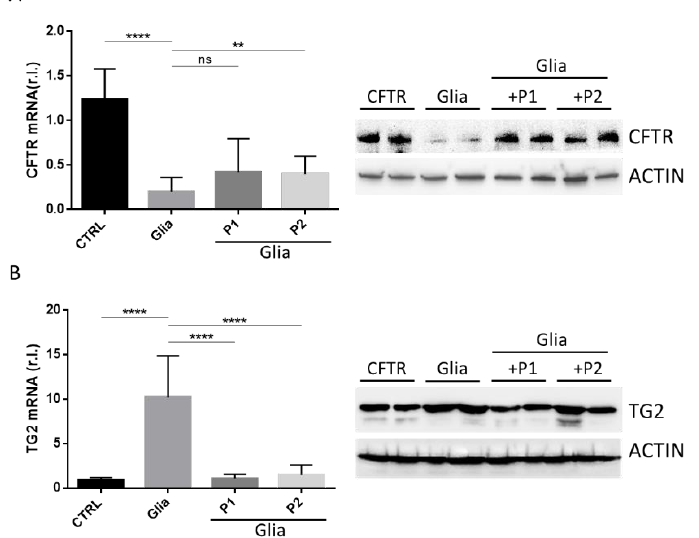
Figure 1. Tissue transglutaminase 2 (TG2) and cystic fibrosis transmembrane conductance (CFTR) modulation by probiotics administration in vivo. CFTR ( A ) and TG2 ( B ) expression levels were evaluated in the small intestine of Balb/c fed third-generation gluten-free mice, treated (Glia) or not treated (CTRL) with gliadin, in the presence or absence of P1 or P2, at both mRNA (left panels) and protein (right panels) levels. Histograms represent mean ± standard deviation (SD) of triplicate sample; **** p < 0.0001; ** p < 0.01; ns = not significant; β -actin was used as loading control in the